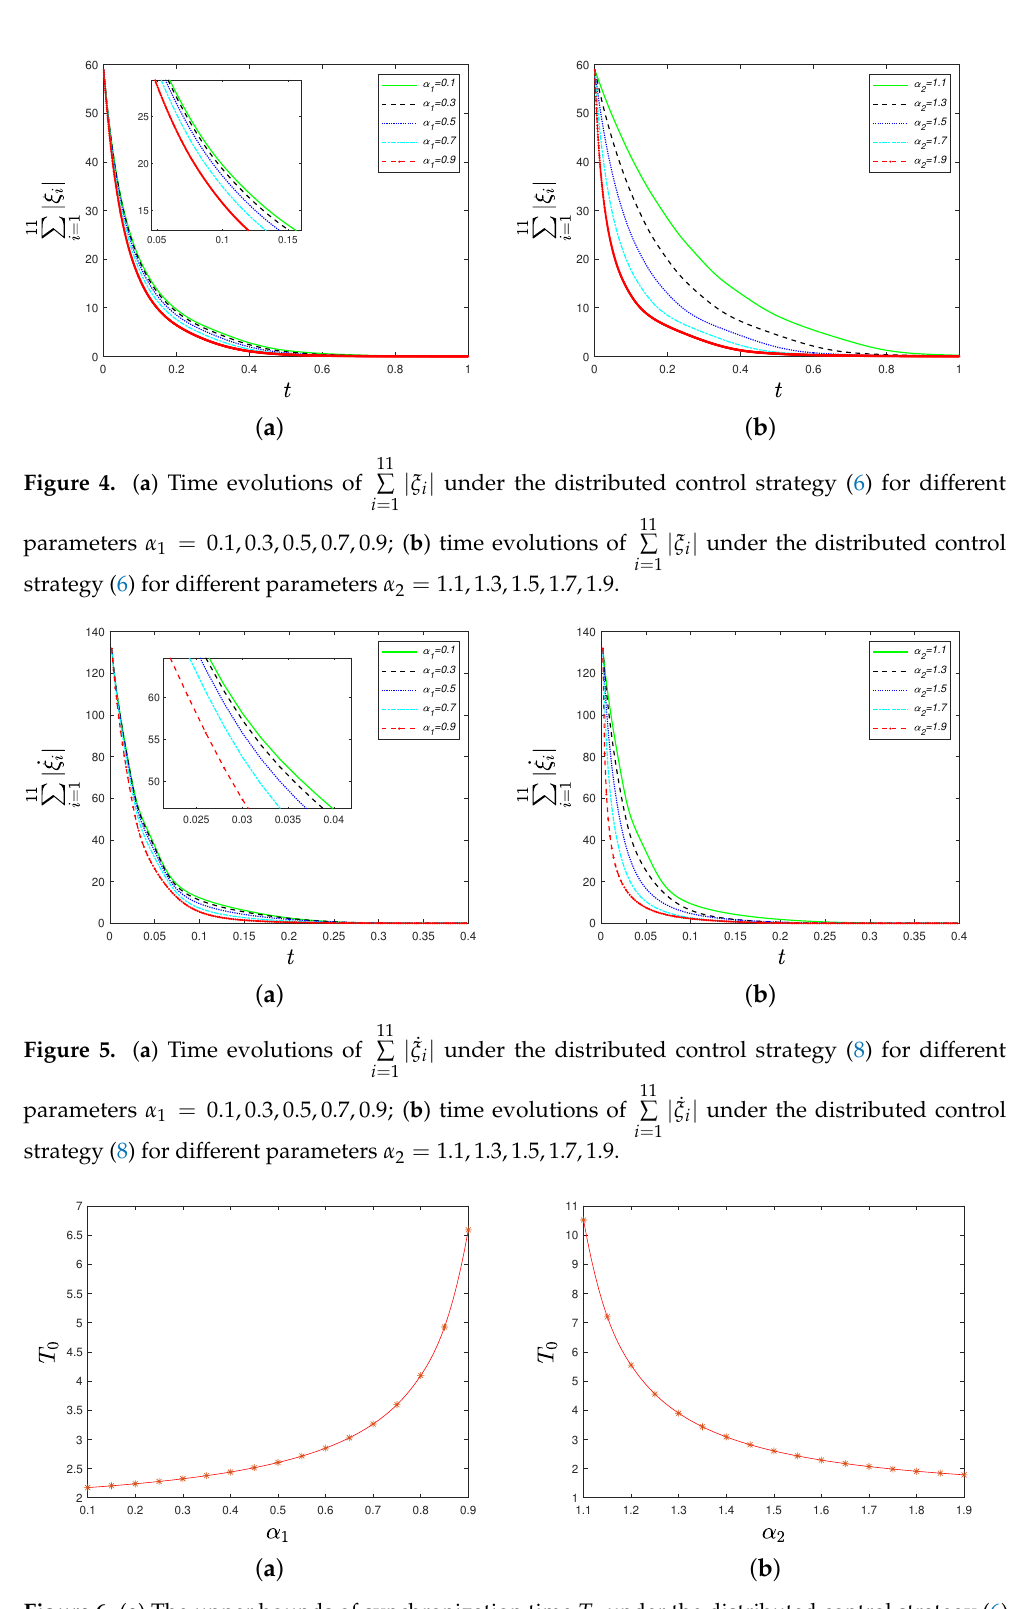
Figure 6. ( a ) The upper bounds of synchronization time T 0 under the distributed control strategy (6) for different parameters α 1 ; ( b ) the upper bounds of synchronization time T 0 under the distributed control strategy (8) for different parameters α 2